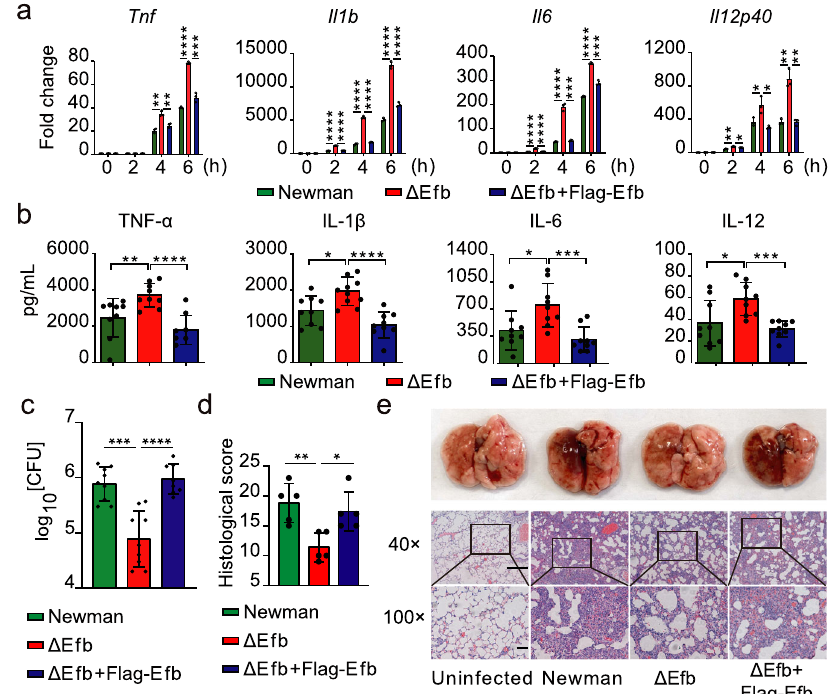
Fig. 1 | Efbinhibits host pro-in fl ammatory responses.a Quantitativepolymerase chain reaction (qPCR) analysis of Tnf , Il1b , Il6 , and Il12p40 mRNA from